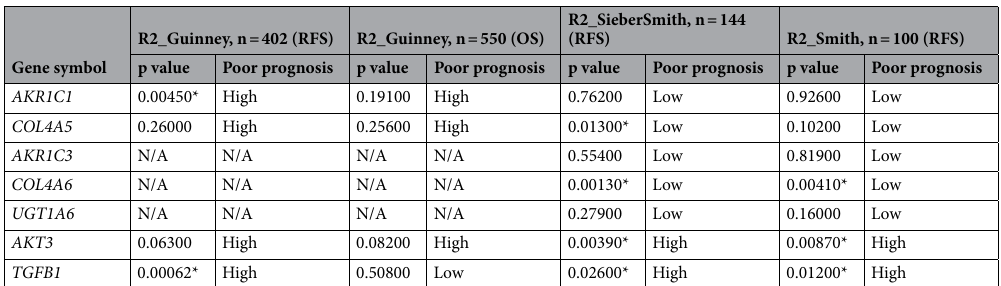
Table 2. Survival analysis of up-regulated key genes. * p <